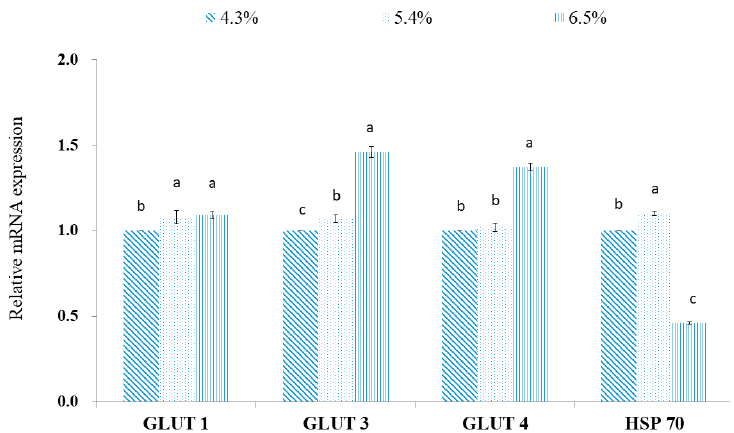
Figure 7. Effect of different acid detergent fiber levels on relative mRNA expression of glucose transport protein (GLUT) and heat shock protein (HSP) 70 in the placenta of sows. a-c Means with different superscripts in the same row differ significantly ( p < 0.05).